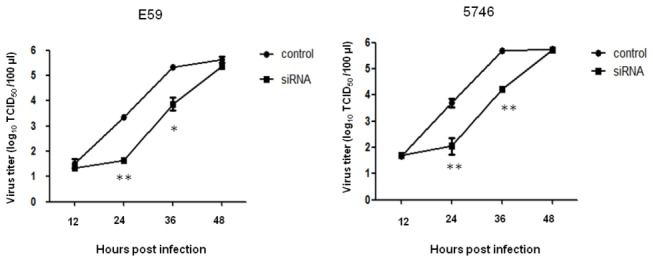
HSP90α/β siRNA inhibits EV71 production.200 pmoles of HSP90α/β siRNA or the same amounts of control siRNA were transfected to RD cells and cultured for 24 hours, Cells were following infected separately with MOI=0.01 of EV71 5746 and E59 strains. Cells were washed after one hour of infection and cultured for another 12, 24, 36, and 48 hours. After cultivation, the supernatants were harvested and subjected to assay virus titer (TCID50) as described in the Materials and Methods. Data represented one of two independent experiments. Unpaired student t test with Welch correction was calculated.